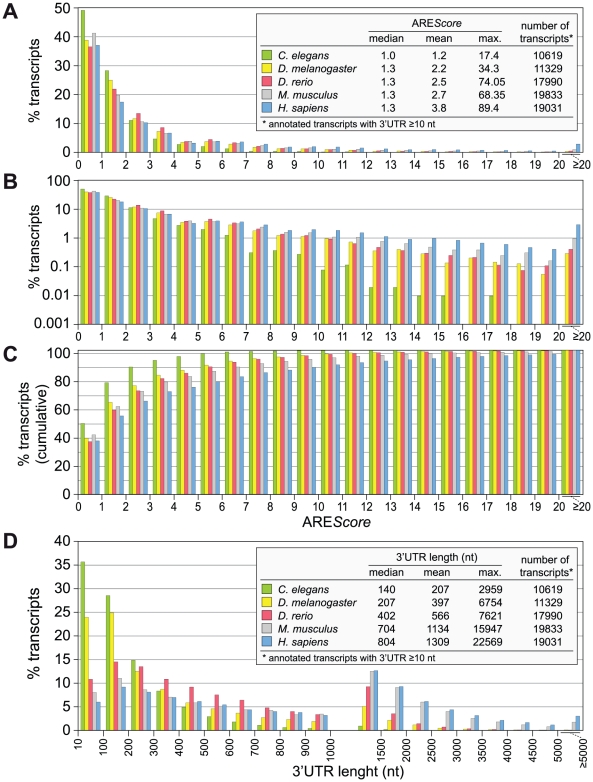
AREScore distribution in different metazoa.(A) The AREScore was determined for every annotated transcript with a 3′UTR length ≥10 nt, for Caenorhabditis elegans, Drosophila melanogaster, Danio rerio, Mus musculus and Homo sapiens. mRNAs were grouped according to AREScores of 0–0.99, 1–1.99, 2–2.99, etc. The graph shows the frequency of mRNAs in each group using a linear scale. (B) The same distribution as in panel A is shown on a logarithmic scale to better visualize the low abundant mRNAs with high AREScores; frequencies of 0 were omitted from the graph. (C) The same distribution as in panel A is depicted using cumulative frequencies on a linear scale. (D) The 3′UTR length distribution was plotted for the same set of transcripts. mRNAs were grouped according to 3′UTR lengths of 10–99, 100–199, 200–299, … 1000–1499, 1500–1999, … 4500–4999, and ≥5000 nt.